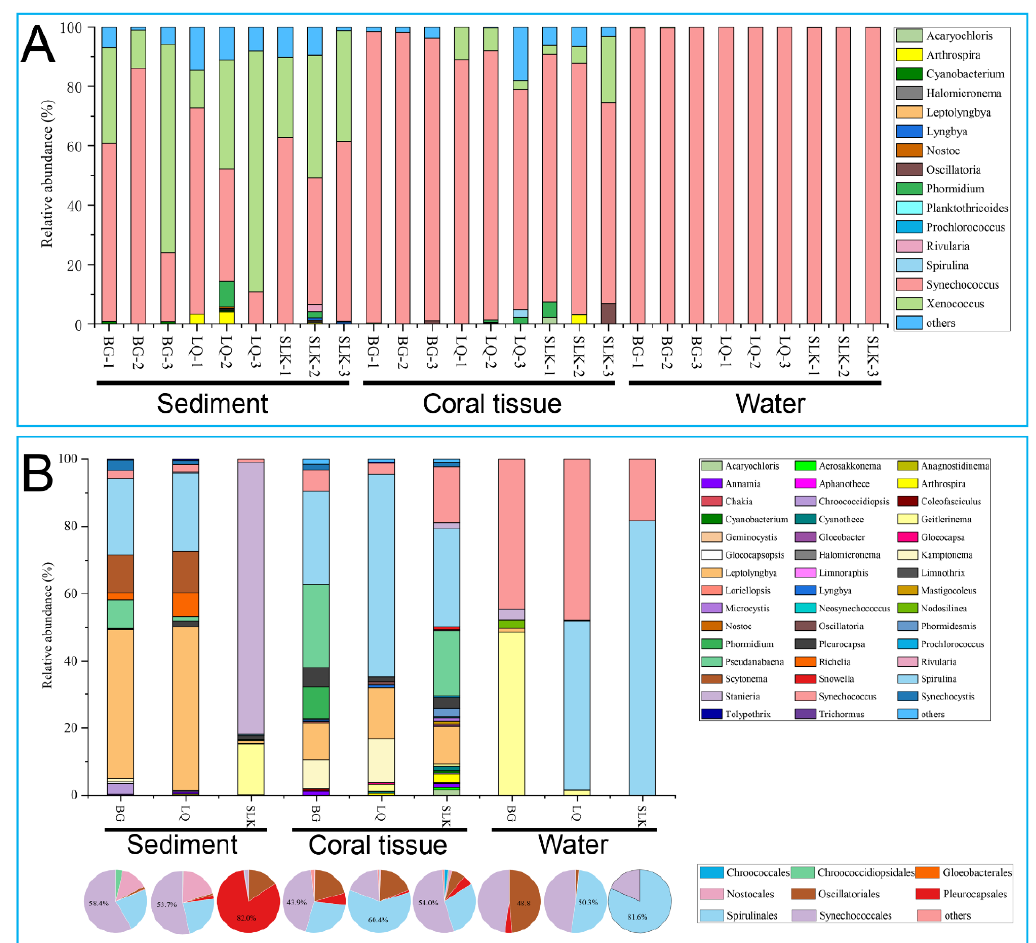
Figure 3. Results of the cyanobacterial community diversity analyses from sequencing reads. ( A ) Stacked bar chart displaying the results of the relative abundances of genera based on universal 16S rRNA gene primers for each site. ( B ) Stacked bar chart displaying the results of the relative abundances of genera based on cyanobacteria-specific 16S rRNA gene primers for each site. Classification of cyanobacterial genera into different orders from each site. Percentages indicate the dominant order(s) of cyanobacteria. BG, LQ, and SLK; with different health statuses representing the slightly damaged, severely damaged and moderately damaged coral reefs,